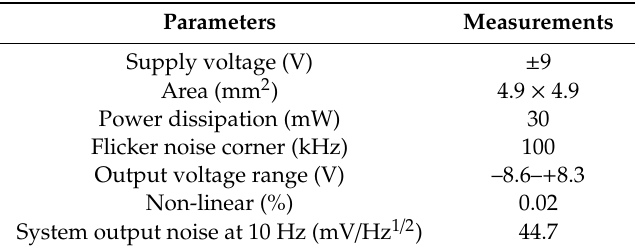
Table 4. Comparison of reported works with this work